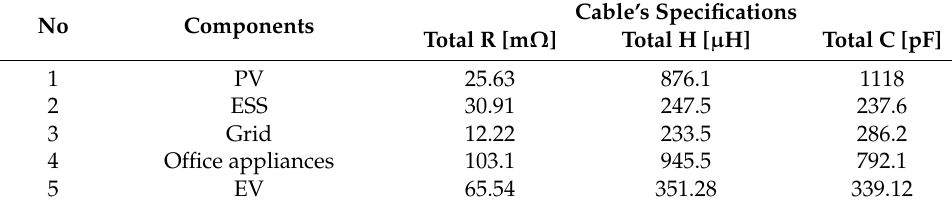
Table A2. Components’